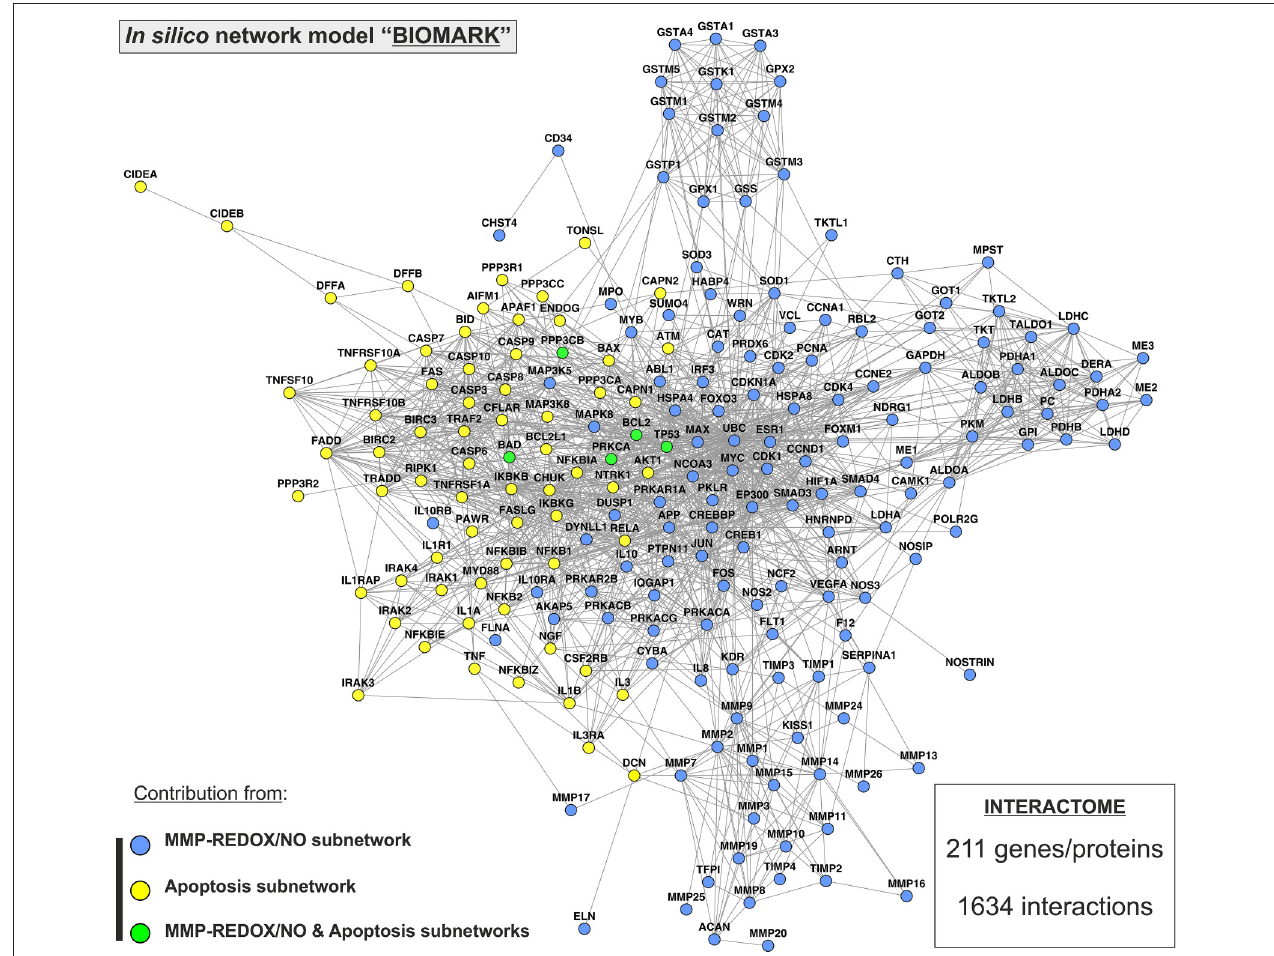
FIGURE 3 | “BIOMARK” interactome. The network model of interactions between genes/protein belonging to “MRN” (MMP-REDOX/NO) and “APOP” (apoptosis) subnetworks or “BIOMARK” interactome was developed by using the STRING 10 database resource search tool, under a confidence score of 0.400, and by using “Databases” and “Experiments” as input options and visualized by plotting it with Cytoscape software. The subnetwork contribution of each gene/protein within the network is represented in the figure with blue-colored (MMP-REDOX/NO), yellow-colored (apoptosis), or green-colored nodes (contributing to both MMP-REDOX/NO and apoptosis